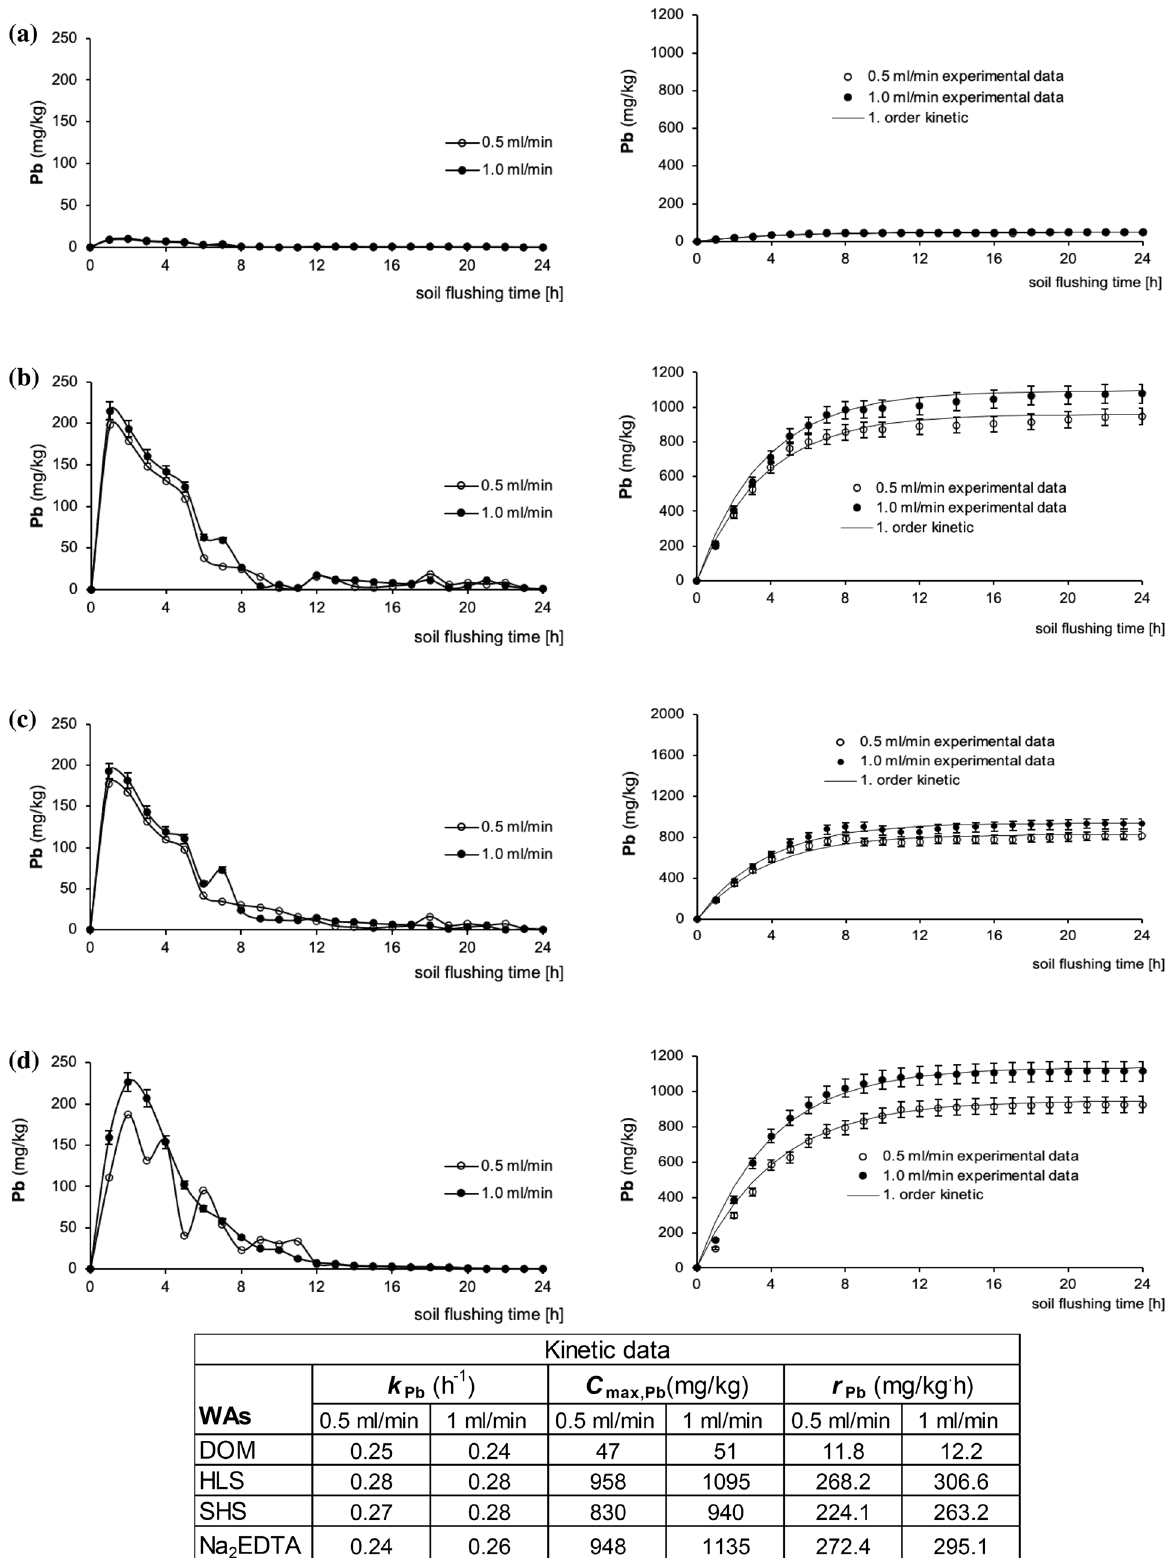
Figure 6. Pb mobilization curves and its cumulative removal during soil flushing at two flow rates with DOM ( a ), HLS ( b ), SHS ( c ), Na 2 EDTA ( d ) with kinetic constants. Data are expressed as mean values (n = 2) ± standard deviation error